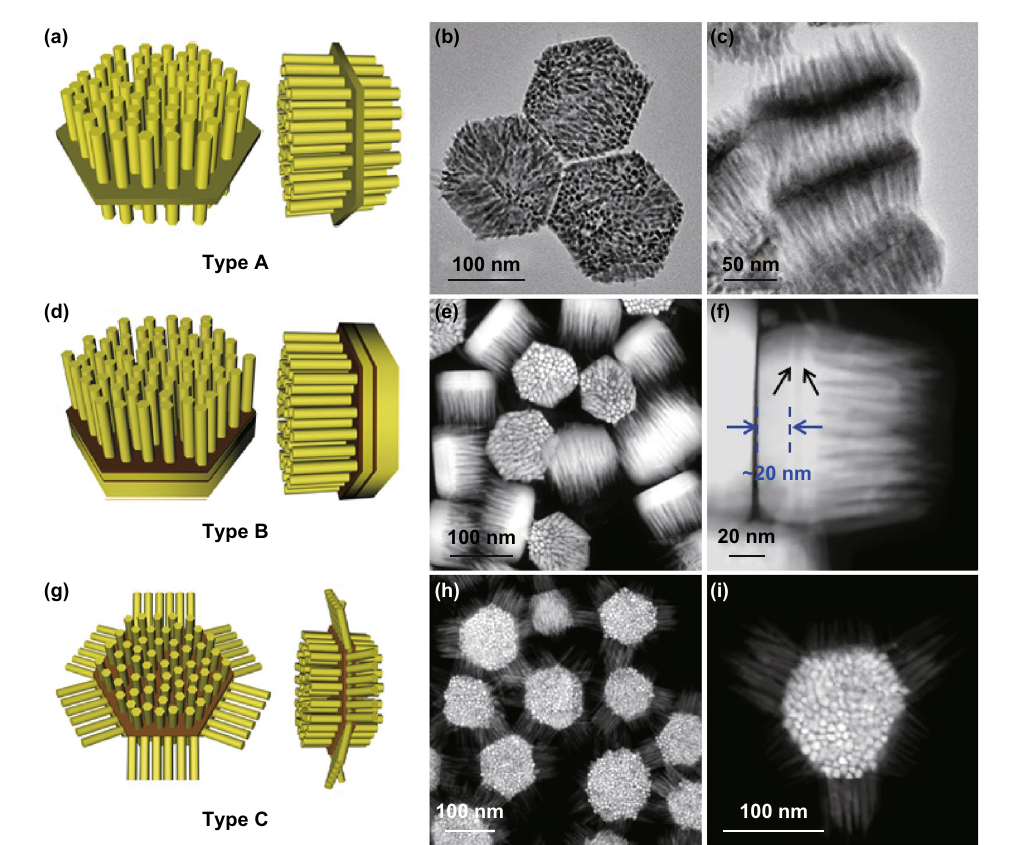
Fig. 7 a Schematic illustration of type A nanostructure. TEM images of CdS‑type A nanostructure lying flat b and standing c on the TEM grids. d Schematic illustration of type B nanostructure. e Dark‑field STEM image of CdS‑type B nanostructures. f Dark‑field STEM image of a typical CdS‑type B nanostructure standing on the TEM grid. Two bright strips, indicated by black arrows, can be clearly observed in the nanostructures. g Schematic illustration of type C nanostructure. h, i Dark‑field STEM images of CdS‑type C nanostructures. Reproduced with permission from Ref. [141]. Copyright 2016, Nature Publishing